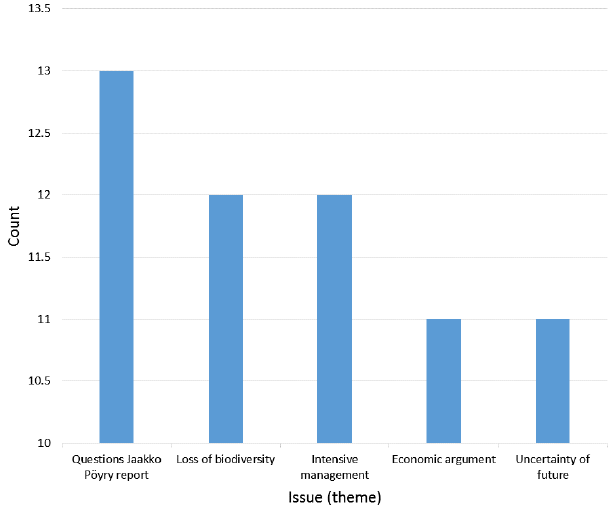
Fig. 1 . Top five issues raised by scientists during Select Committee on Wood Supply